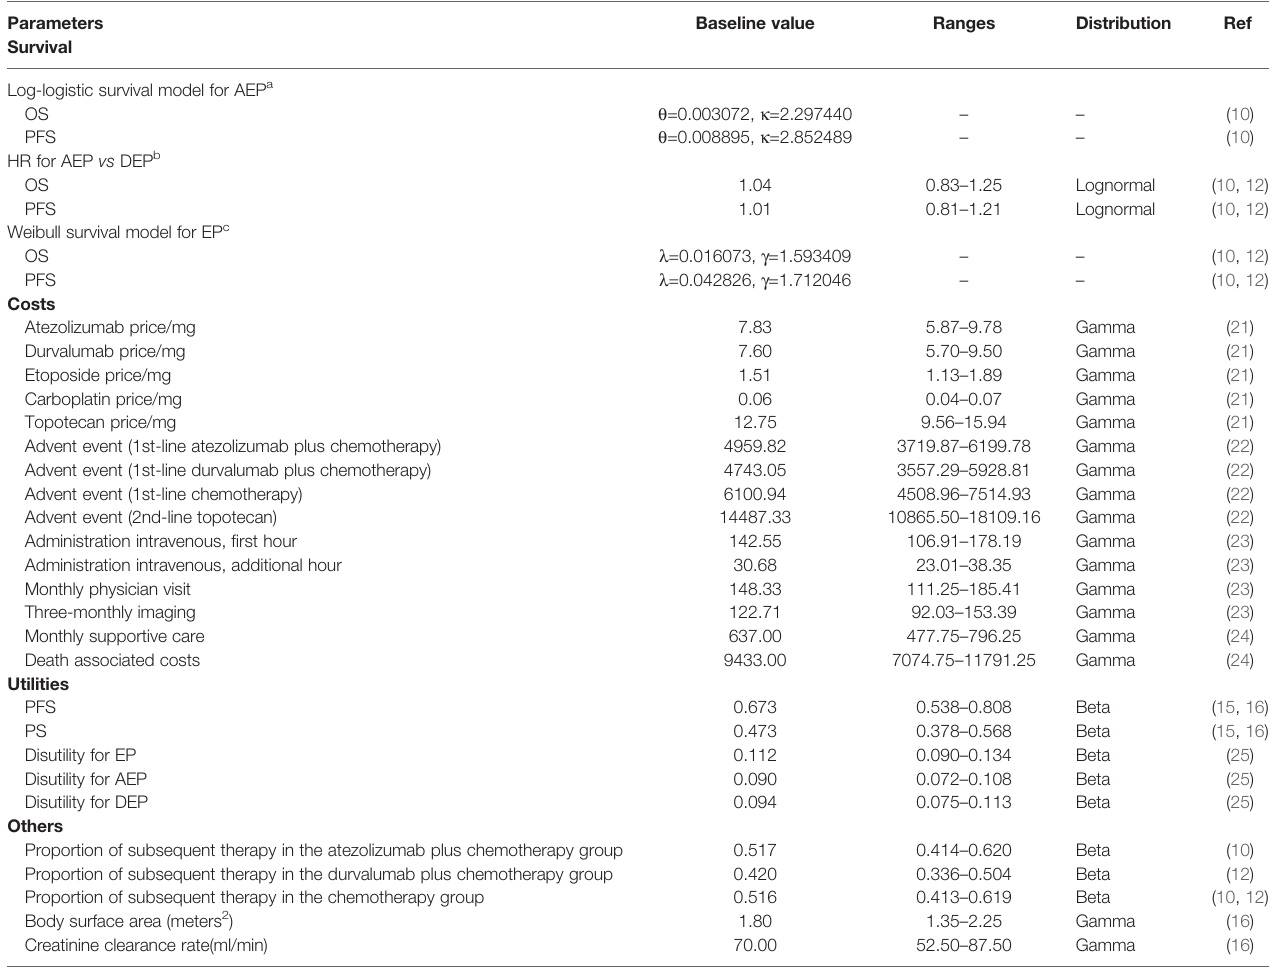
TABLE 1 | Model Parameters and